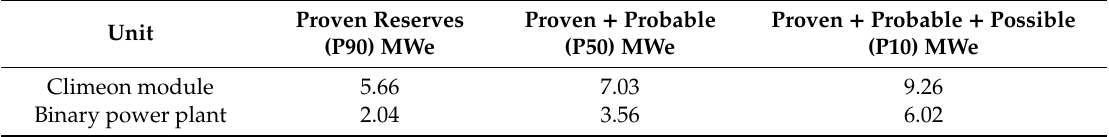
Table 3. Results of the Monte Carlo simulation for Sete Cidades, both the Climeon module and binary power plant.